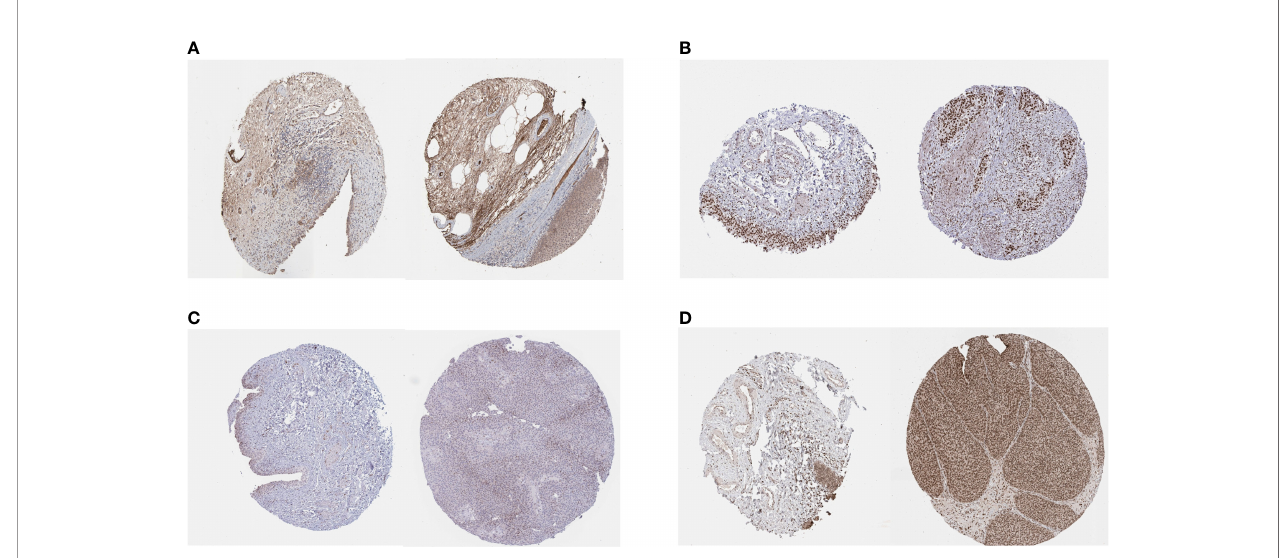
FIGURE 10 | IHC staining of (A) PSMD14, (B) PRPF19, (C) PSMB5, and (D) TPR in normal tissues (left) and bladder cancer tissues